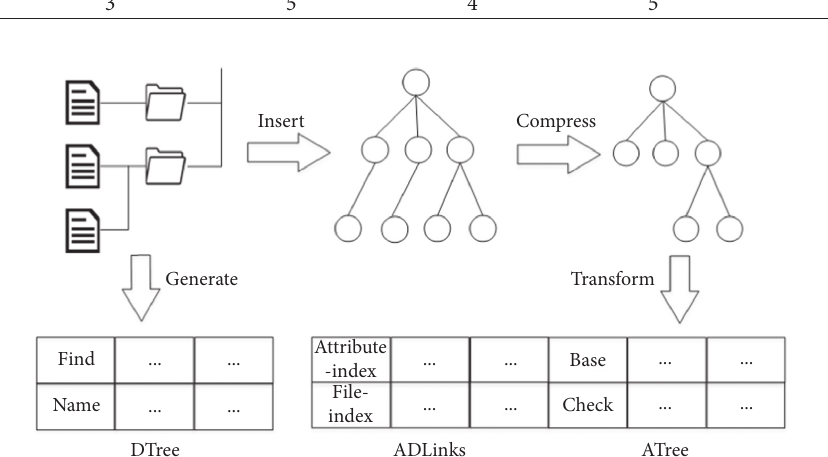
Figure 8: The process of building an